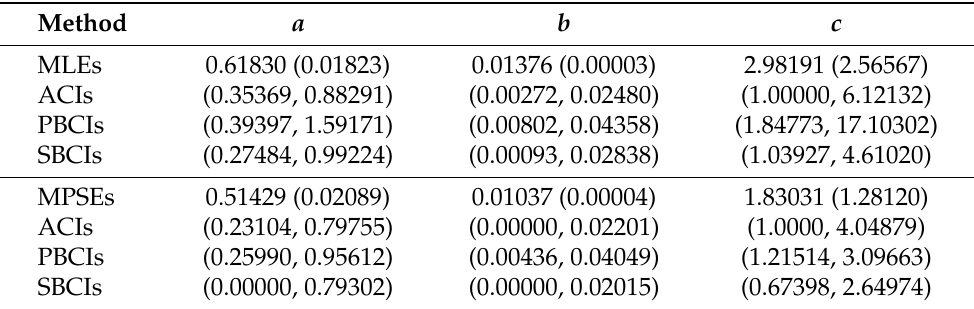
Table 10. The MLEs, MPSEs and the corresponding standard errors (in parentheses) and the different 95% CIs for the breakdown of steel Type-II censored CSPALT